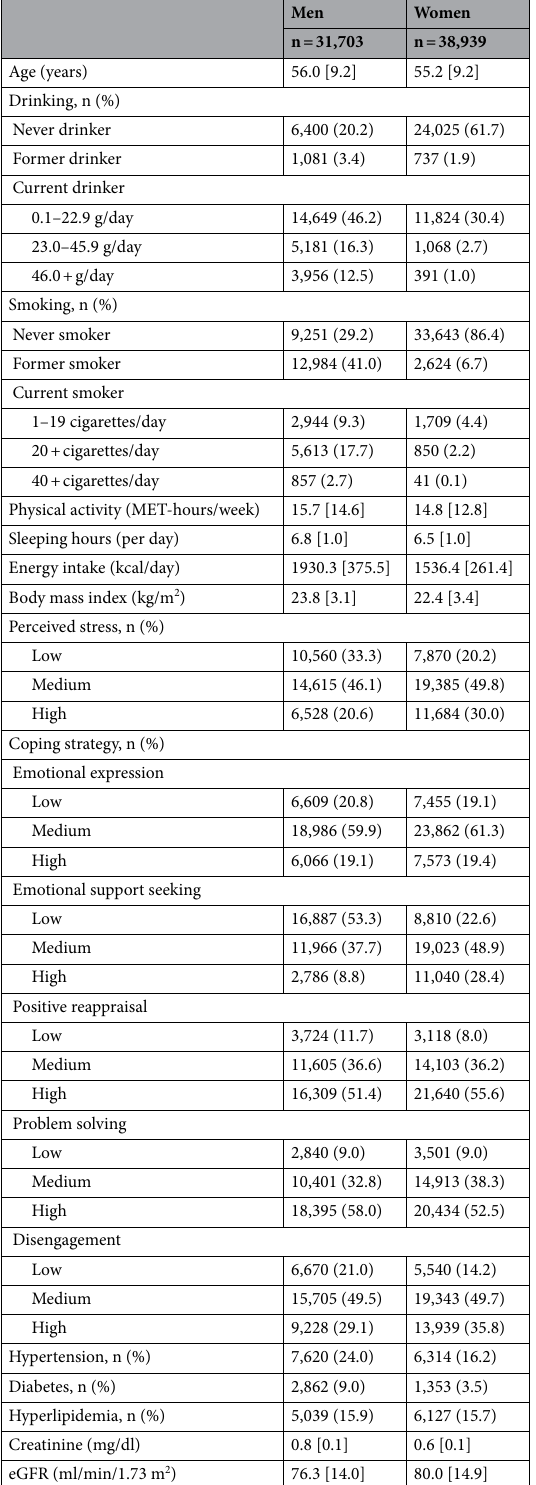
Table 1. Characteristics of the study subjects by gender. Data represent the mean [standard deviation] or number (percentage). Some data were missing for drinking (number of men/number of women,